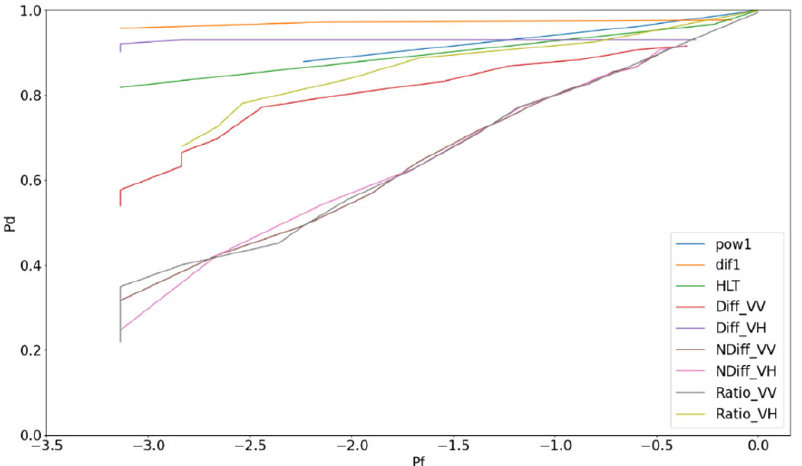
Figure 10. ROC Curve in a Log10 format showing Potpecko Lake Data change detectors: Difference VV & VH (Diff_), Ratio VV & VH (Ratio_), Normalised Difference (NDiff_), Power Difference (Dif1), Power Ratio (Pow1), and Trace (HLT).